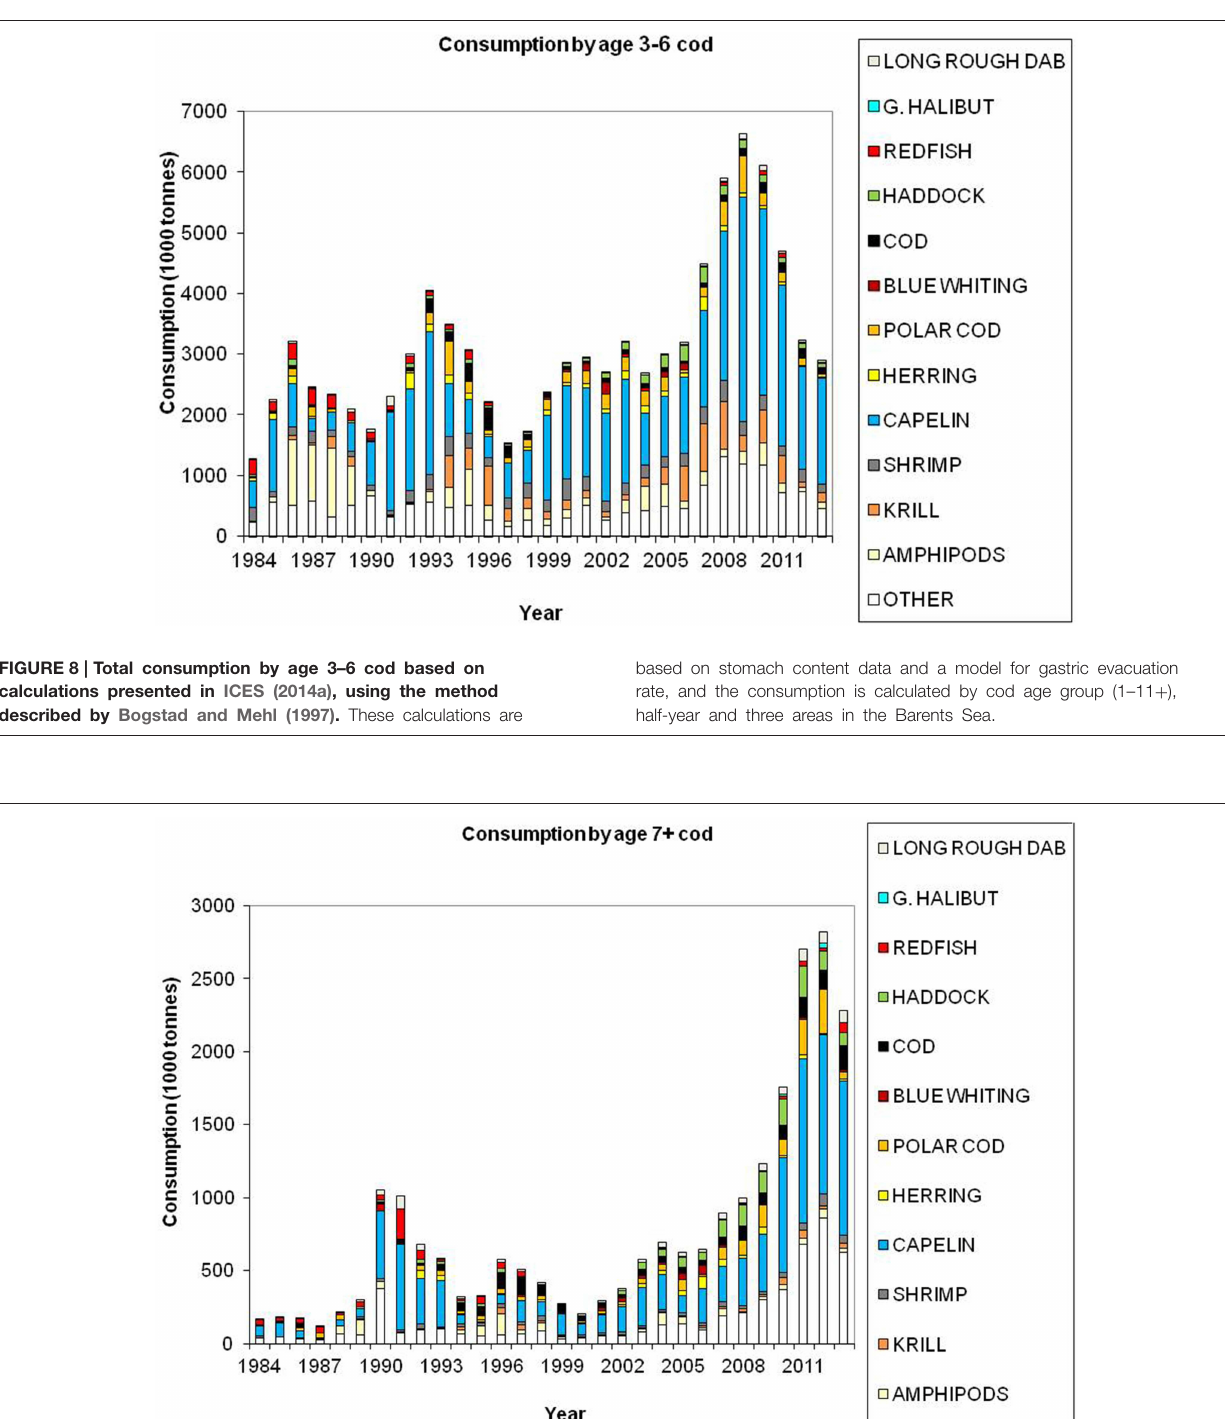
based on stomach content data and a model for gastric evacuation rate, and the consumption is calculated by cod age group (1–11 + ), half-year and three areas in the Barents